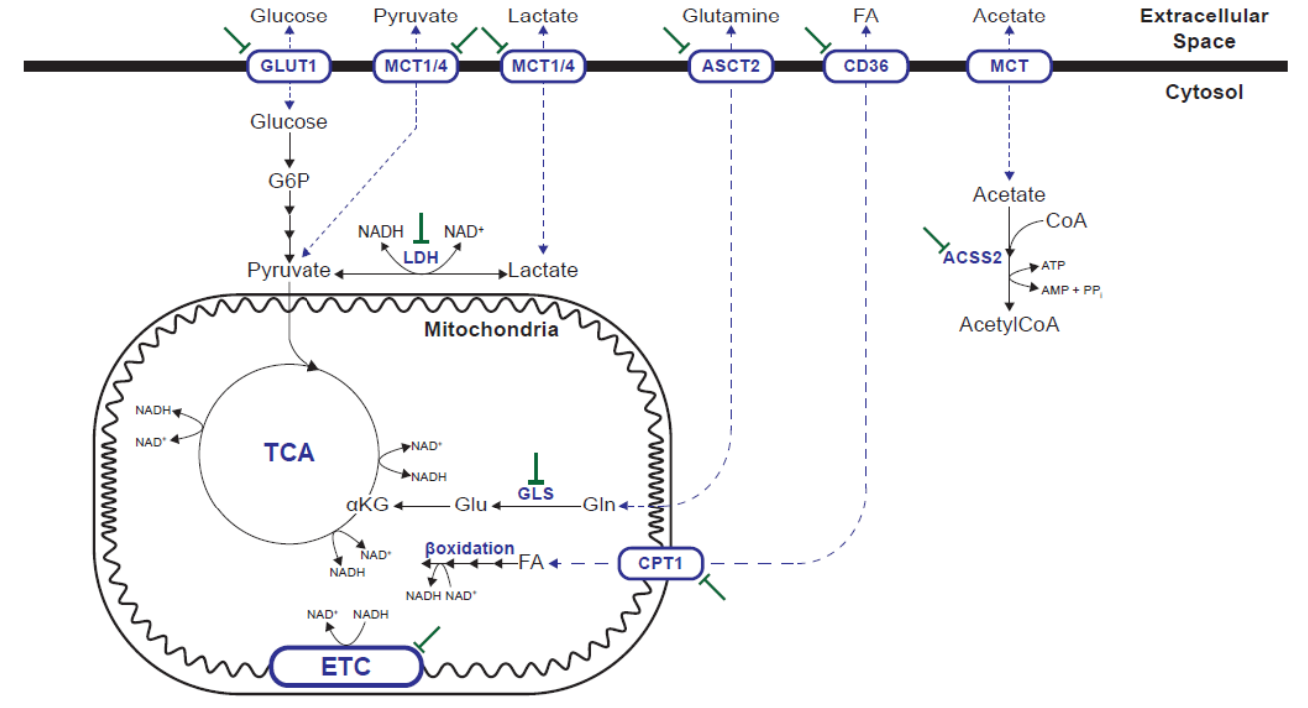
Figure 1. Metabolic pathways supporting biosynthesis and energy production in cancer cells that can be pharmacologically targeted. GLUT1: glucose transporter 1; MCT: monocarboxylate transporter; ASCT2: alanine, serine, cysteine transporter 2, SLC1A5; LDH: lactate dehydrogenase; ACSS2: acetyl-CoA synthetase 2; GLS: glutaminase. CPT1: carnitine palmitoyltransferase 1; ETC: electron transport chain.